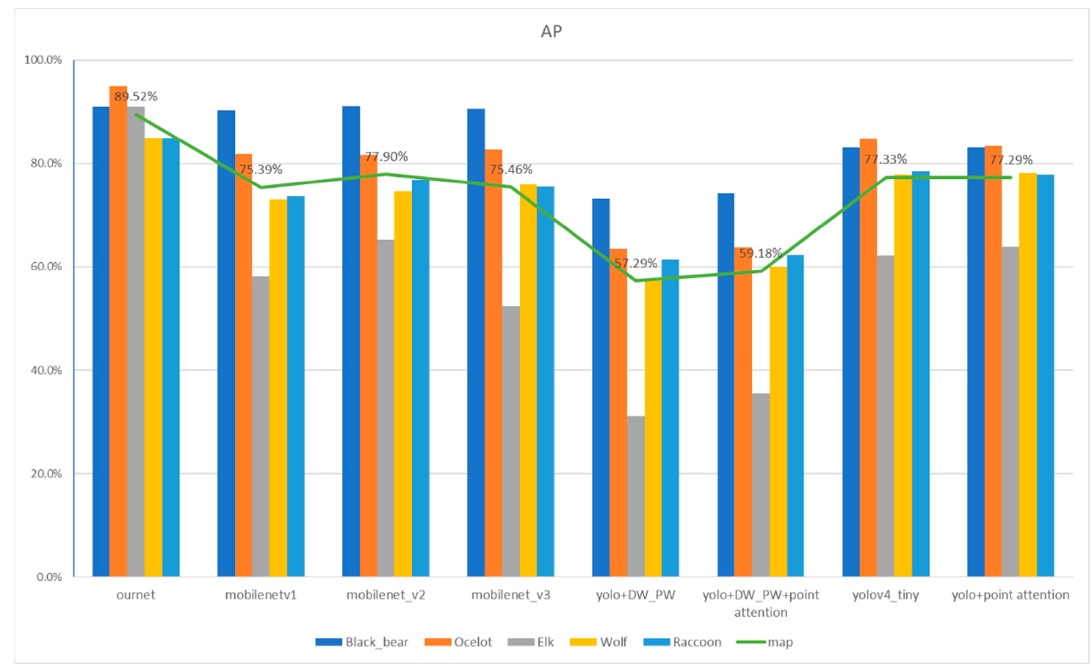
Figure 7. Performance comparison of different models.